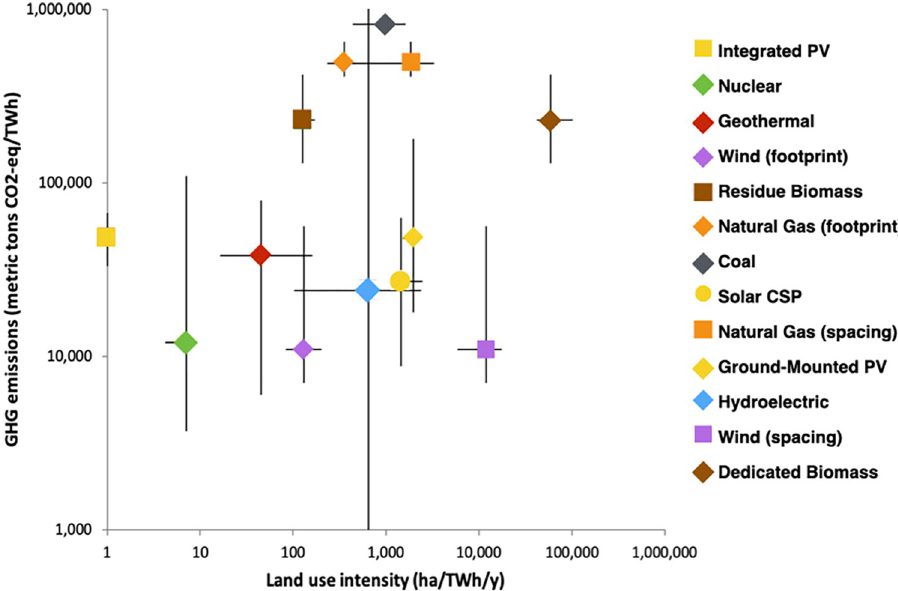
Fig 2. Relationship between the land use intensity of electricity (ha/TWh/y) and lifecycle GHG emissions (metric tons CO 2 -eq/TWh) on a log scale. Error bars represent interquartile range. GHG emissions source data: IPCC Fifth Assessment, Working Group III